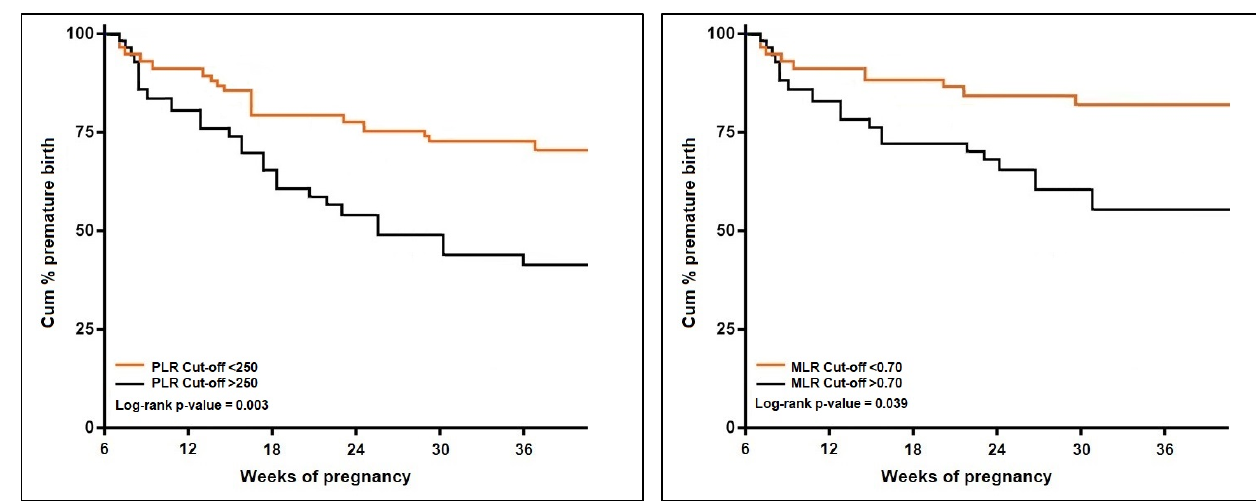
Figure 5. Kaplan–Meier probability analysis of premature birth by PLR and MLR scores.